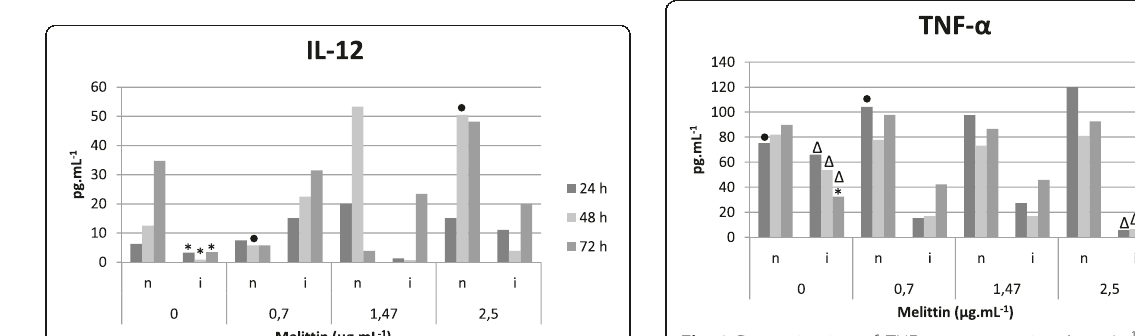
Fig. 3 Determination of TNF- α concentration (pg.mL − 1 ) in the supernatant of uninfected macrophages ( n ) and infected macrophages ( i ) after melittin treatment (0, 0.7, 1.47 and 2.5 μ g.mL − 1 ) at 24, 48 and 72 h. Data are presented as mean of three independent measurements. * p <0.05 for 72 h infect cells versus 24, 48 and 72 h non-infected cells, without melittin addition. ● p <0.05, for 24 h treatment with 0.7 μ g.mL − 1 melittin versus non-infected cells. Δ p <0.05 for 24, 48 and 72 h treatment with 2.5 μ g.mL − 1 melittin versus infected non-treated cells